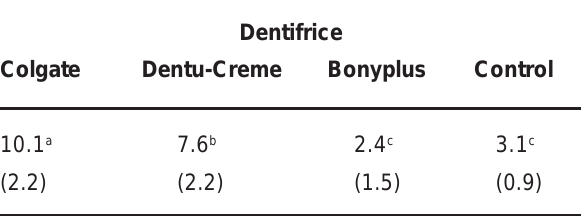
Means with the same letter are not significantly